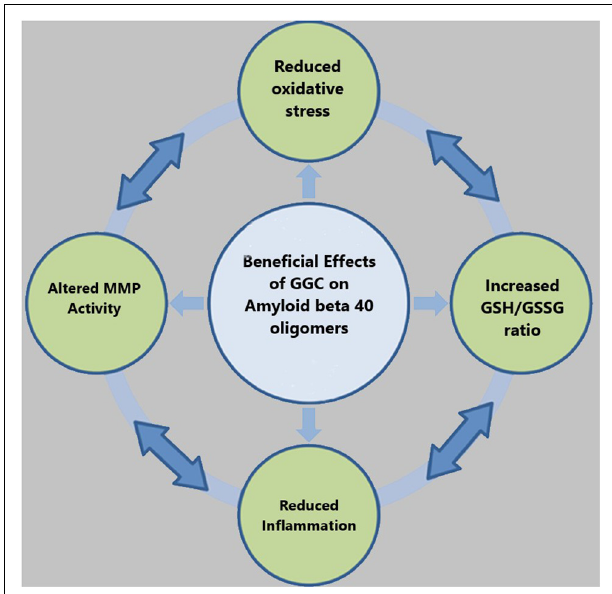
FIGURE 6 | GGC can protect against oligomeric A β 40 toxicity by reducing oxidative stress and increasing GSH